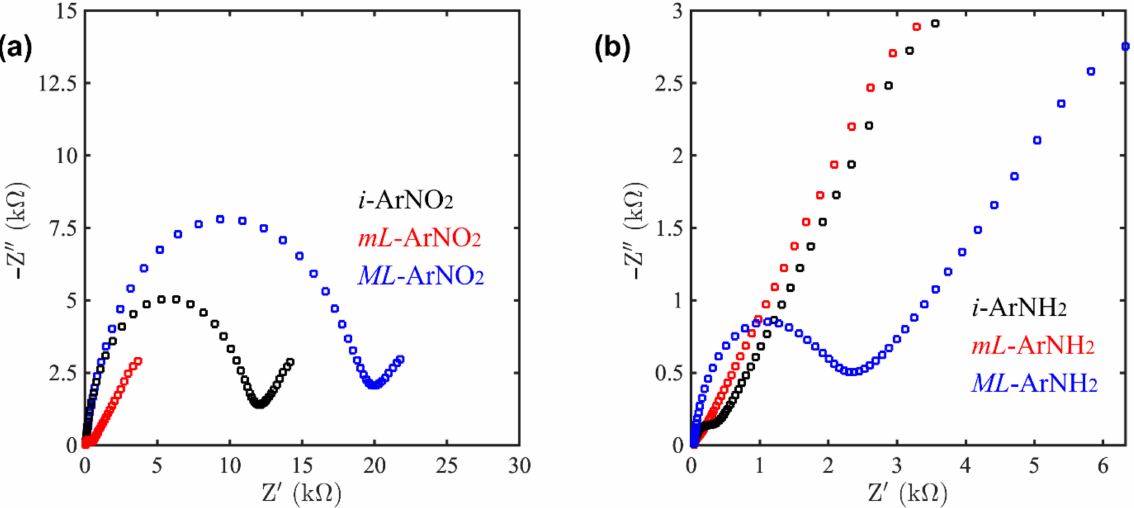
Figure 3. Impedance spectra (Nyquist plots) obtained from the modification ( a ) Au/ i -ArNO 2 (black), Au/ mL -ArNO 2 (red) and Au/ ML -ArNO 2 (blue); ( b ) Au/ i -ArNH 2 (black), Au/ mL -ArNH 2 (red) and Au/ ML -ArNH 2 (blue); polycrystalline gold electrode with 2.5 mM Fe(CN) 63 − / 4 − each, and 0.5 M KNO 3 support electrolyte.